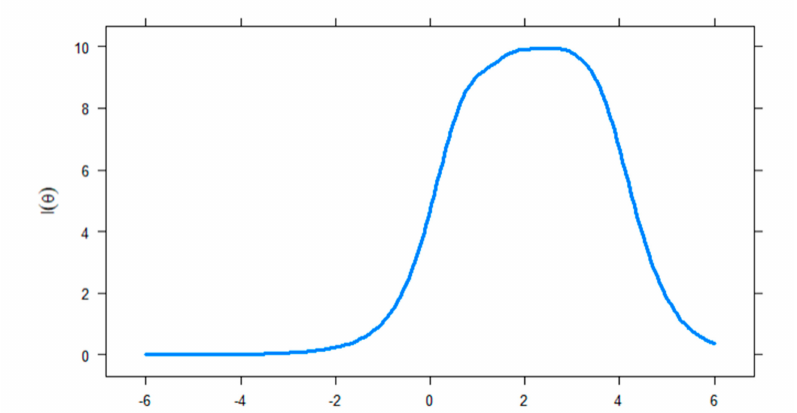
Figure 4. Test information curve of the Internet Gaming Disorder Scale-Short Form